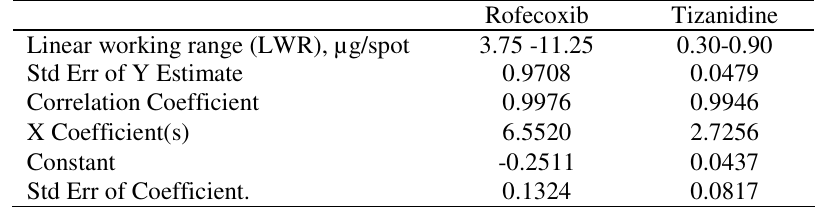
Table 1. Analytical performance data (Linear regression data for calibration curve)